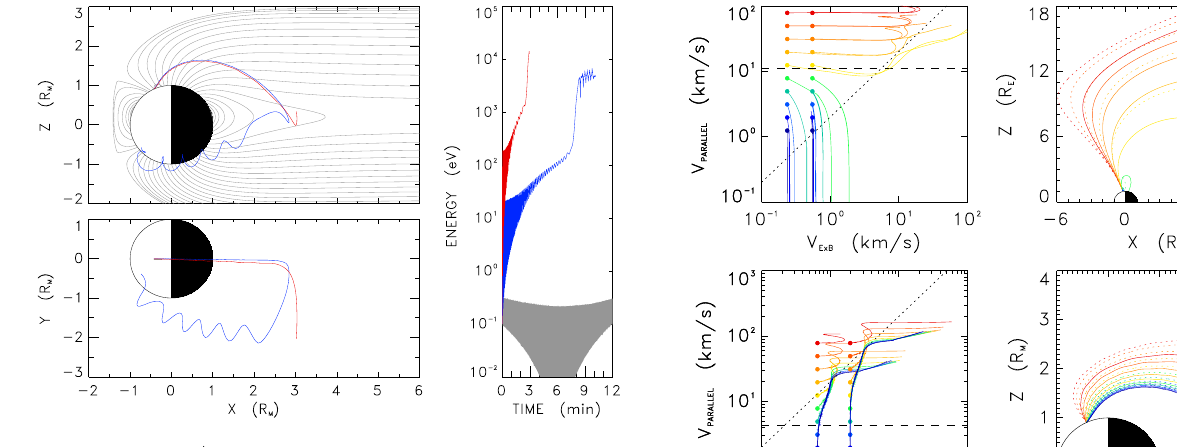
Fig. 2. Model Na + trajectories: (Left) projections in the noon- midnight meridian plane (top) and in the equatorial plane (bottom), (right) kinetic energy versus time. The test ions are launched from 65 ◦ latitude with 0.1eV energy on the noon meridian. Three dis- tinct cross-polar cap potential drops are considered: 1kV, 10kV, and 30kV (coded in grey, blue, and red, respectively).